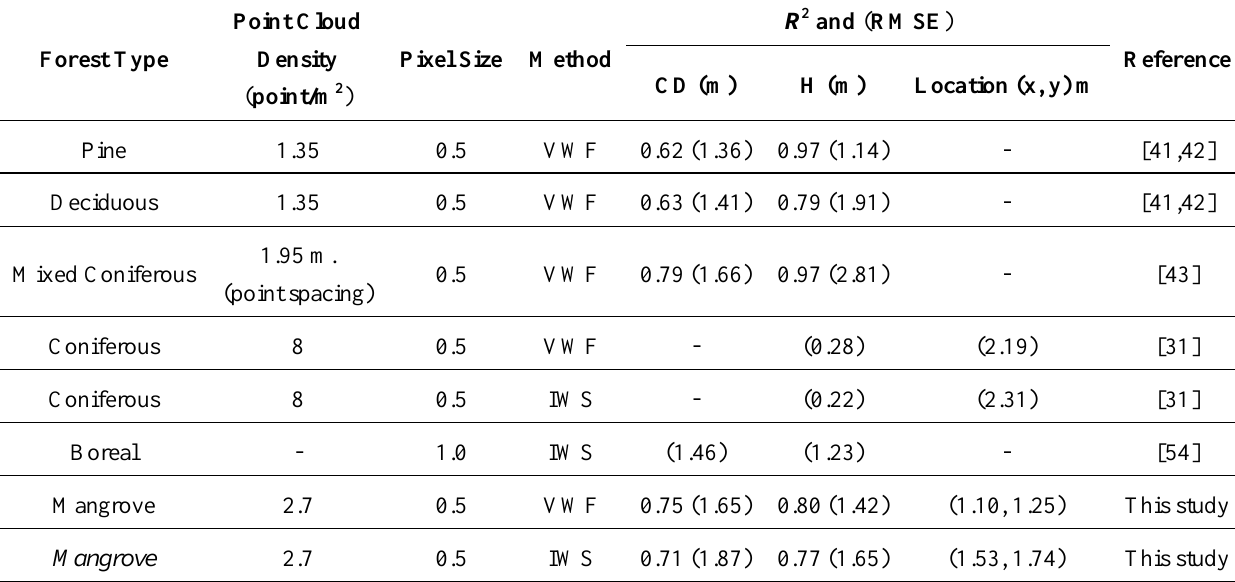
Table 8. Accuracy of LiDAR-derived biophysical parameters using the VWF and IWS methods in mangrove forests compared with other forest types.